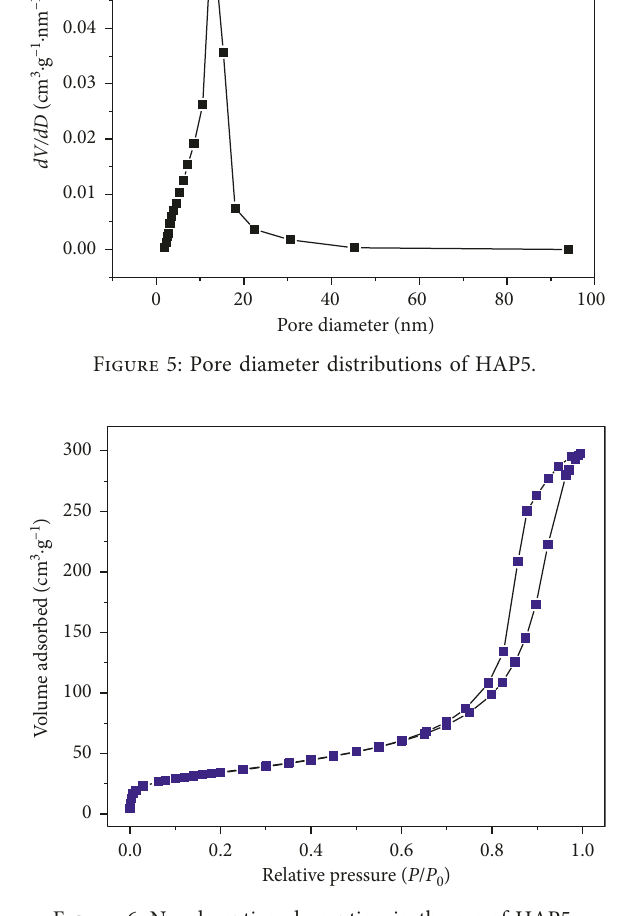
Figure 6: N 2 adsorption-desorption isotherms of HAP5.